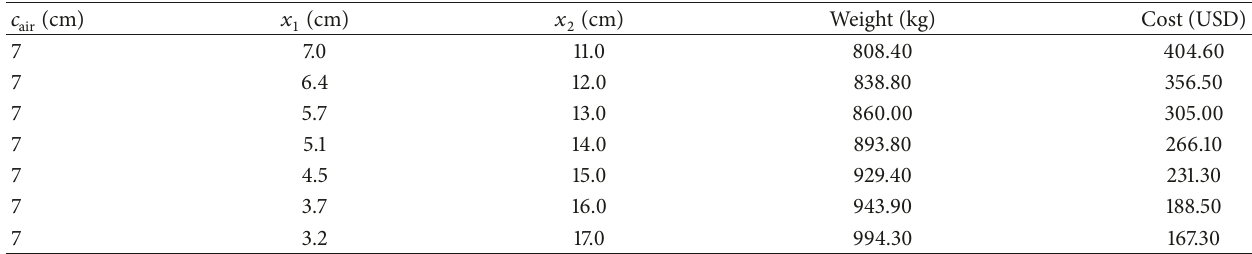
Table 2: Container’s weight and cost from the optimal solution by